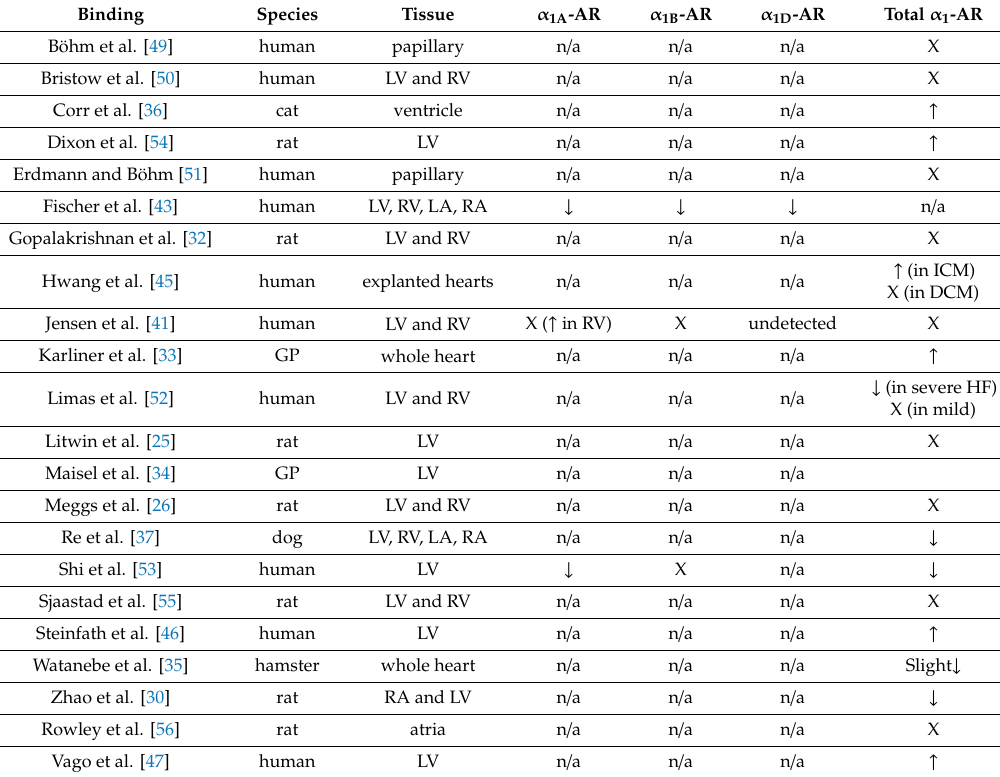
Table 2. Summary of cardiac α 1 -adrenoceptor (AR) protein expression in chronic heart